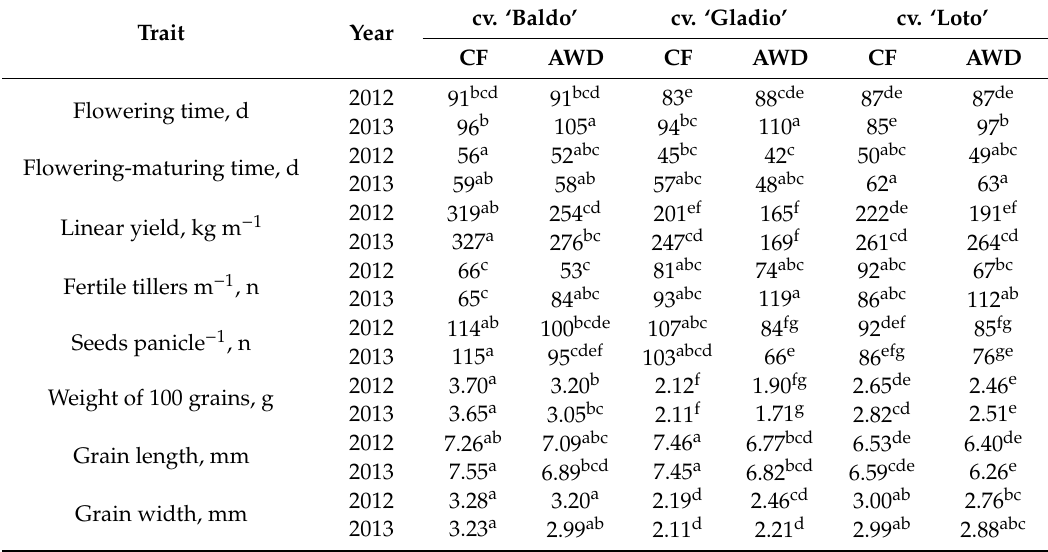
Table 1. Plant phenology, yield and grain morphology of three rice cultivars grown under continuous flooding (CF) or alternate wetting and drying